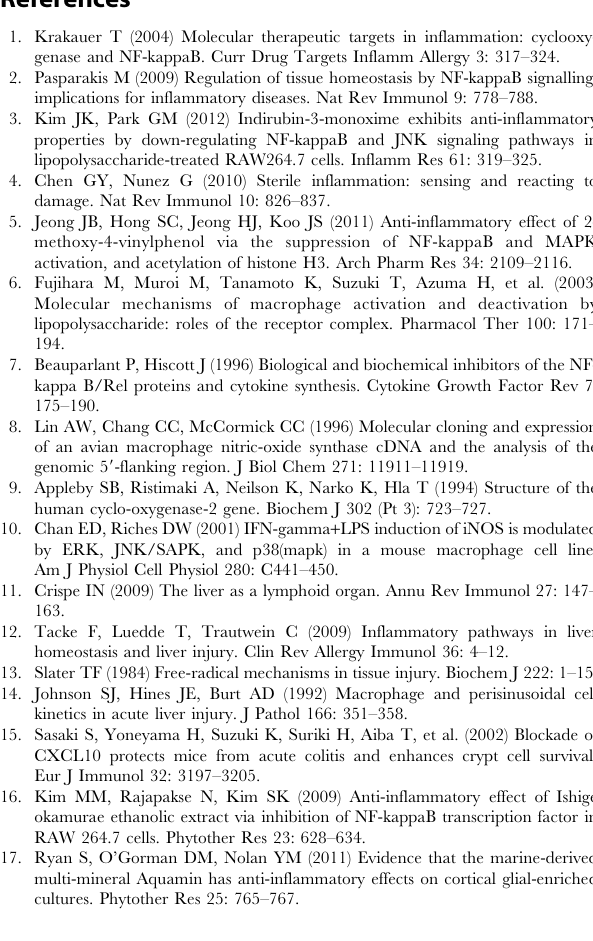
with 1 m g/ml LPS for 24 h. Treatment of PBS buffer and 1 m M Taxol served as the negative (mock) and positive control, respectively. Cell viability was measured by the flow cytometry using Annexin V/propidium iodide. (TIF) Figure S3 Effect of AEGT on the production and gene expression of proinflammatory cytokines in IFN- c or TNF- a -stimulated RAW 264.7 cells. The RAW264.7 cells were seeded in a 24-well plate, treated with 400 or 800 m g/ml AEGT for 1 h, and then incubated with 2.5 ng/ml TNF- a or 200 UI IFN- c for 24 h. The RNA levels of proinflammatory cytokines induced by TNF- a (A, B and C) and IFN- c (D, E and F) were analyzed by qRT-PCR, respectively. The efficiency of inhibition was determined as the percent RNA levels relative to those in the cells treated with IFN- c or TNF- a alone. Error bars indicate the means 6 SD of three independent experiments. * P , 0.05; ** P , 0.01. Figure S4 Effect of AEGT on the production and gene expression of proinflammatory cytokines in LPS-pre- stimulated RAW 264.7 cells. The RAW264.7 cells were seeded in a 24-well plate, treated with 1 m g/ml LPS for 6 h, and then incubated with 400 or 800 m g/ml AEGT for 24 h. The RNA (A, B and C) and secreted protein levels (D, E and F) of proinflammatory cytokines were analyzed by qRT-PCR and ELISA, respectively. The efficiency of inhibition was determined as the percent RNA levels relative to those in the cells treated with